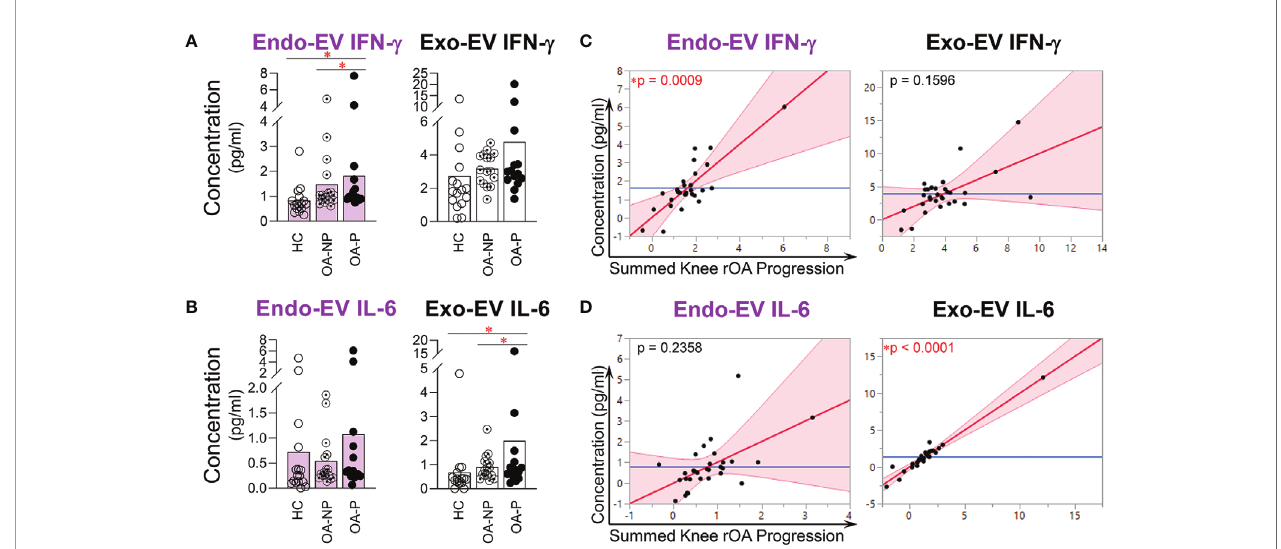
FIGURE 4 | The concentrations of endo-EV IFN- g and exo-EV IL-6 at baseline were associated with knee rOA progression. The concentrations of exo-EV and endo- EV IFN- g and IL-6 in plasma from HC (n = 16), OA-NP (n = 16) and OA-P (n = 14) participants at baseline were measured by multiplex immunoassay. (A, B) The graphs represent the differential concentrations of endo-EV and exo-EV IFN- g (A) and IL-6 (B) between HC, OA-NP and OA-P. Comparisons between HC, OA-NP and OA-P were performed using Kruskal-Wallis test with signi fi cant results de fi ned by FDR q < 0.05; asterisks indicate the p value as * < 0.05. (C, D) Multivariable linear regression modeling was performed with adjustment for the baseline clinical variables to identify the associations of summed knee rOA progression from baseline to follow-up with the baseline concentrations of IFN- g and IL-6 in OA participants (n = 30, 53% OA-NP and 47% OA-P). The Leverage Plots represent plots of leverage of summed knee rOA progression (x axis) vs the baseline concentrations (y axis) of endo-EV and exo-EV IFN- g (C) and IL-6 (D) . Endo-EV, within EV; Exo- EV, outside EV; HC, healthy control; OA-P, radiographic knee osteoarthritis progressor; OA-NP, radiographic knee osteoarthritis